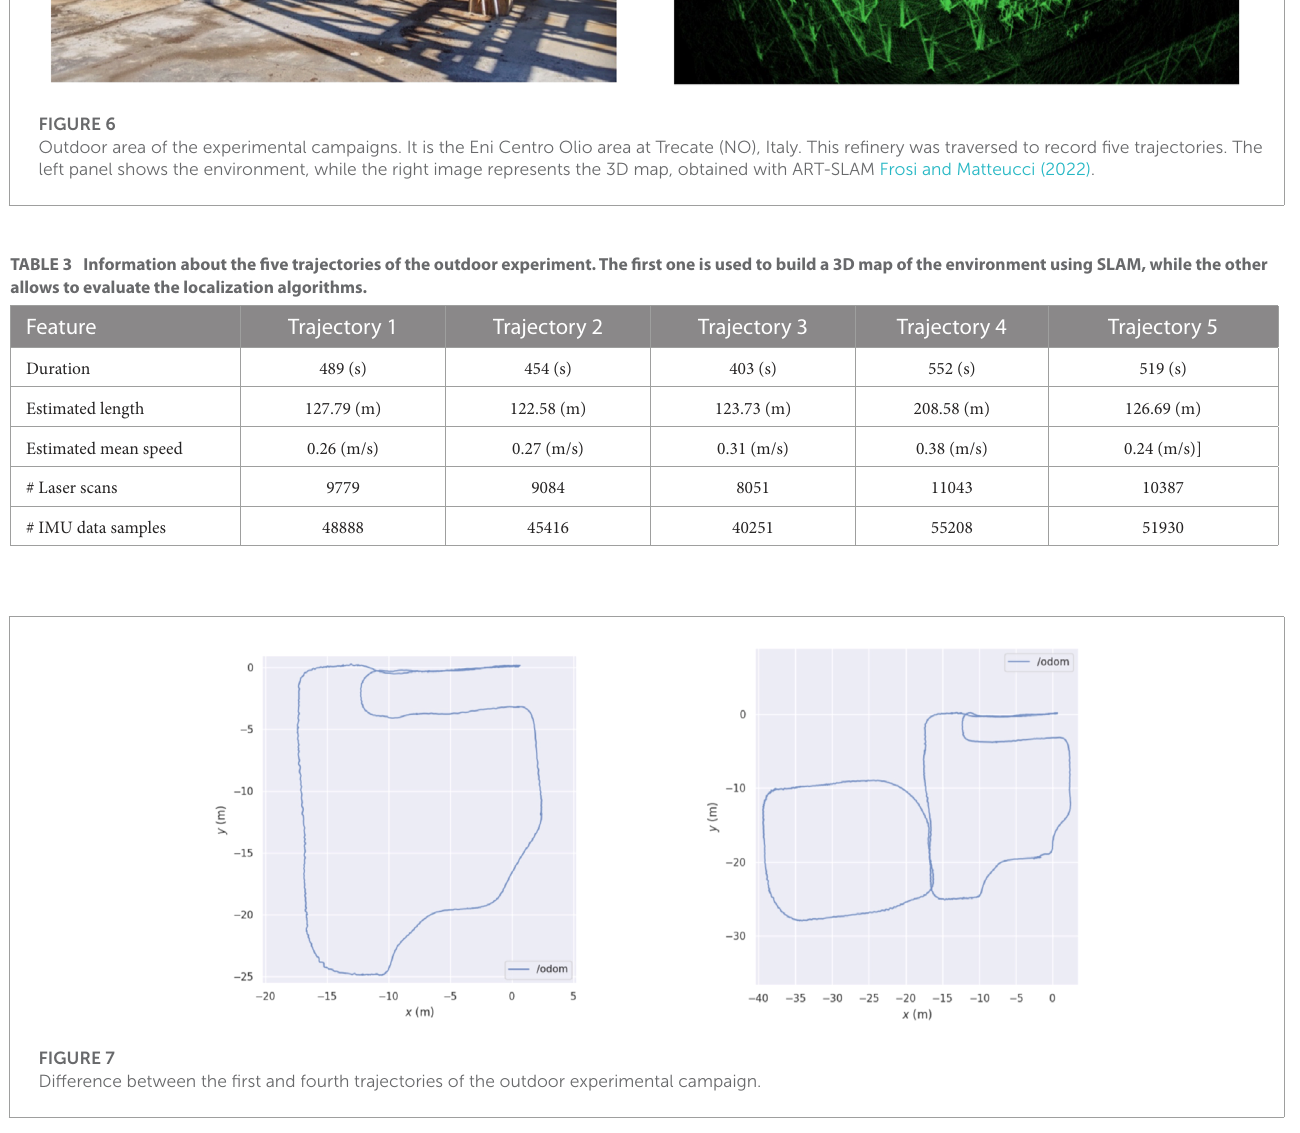
Despite the low number of samples (the ten areas considered for re-localization), both Figures 4 , 5 confirm that the length of a trajectory, or the acquisition time, are not correlated to the attained precision. Both tested systems rely on UKF localization, with a correction step performed via scan-to-map point cloud alignment; this way, possible localization errors are bounded by the residual error of the previous scan and the error in one step